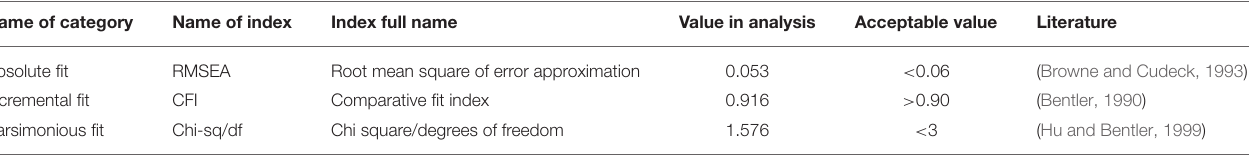
TABLE 5 | Structural equation modeling – model fitness test.